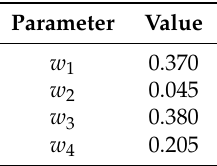
Table 2. Parameter values using responses from the 27th week of 2017 to 26th week of